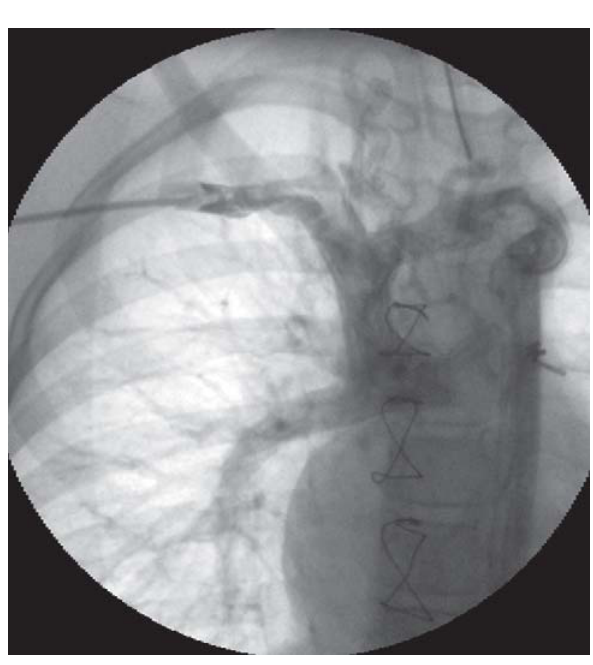
Fig. 4 – Injeção de contraste em veia subclávia direita demonstrando a veia cava superior conectada ao sistema arterial pulmonar. Nota-se, também, o enchimento da veia inominada com drenagem importante em sentido retrógrado pela veia hemiázigo ao sistema da veia cava inferior